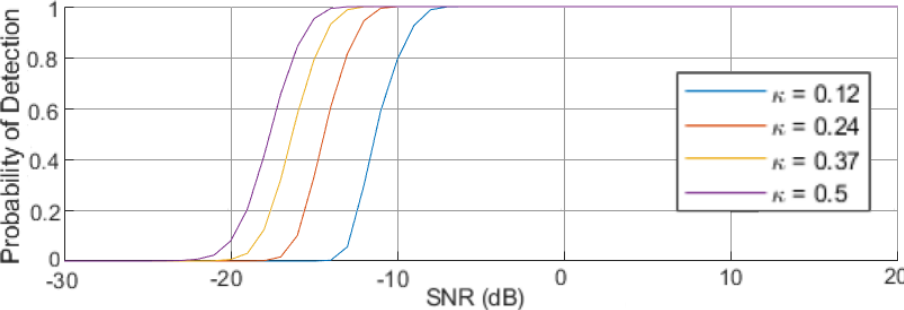
Figure 6. Detector performance for simulated satellite signal in a white Gaussian noise (WGN) envi- ronment.